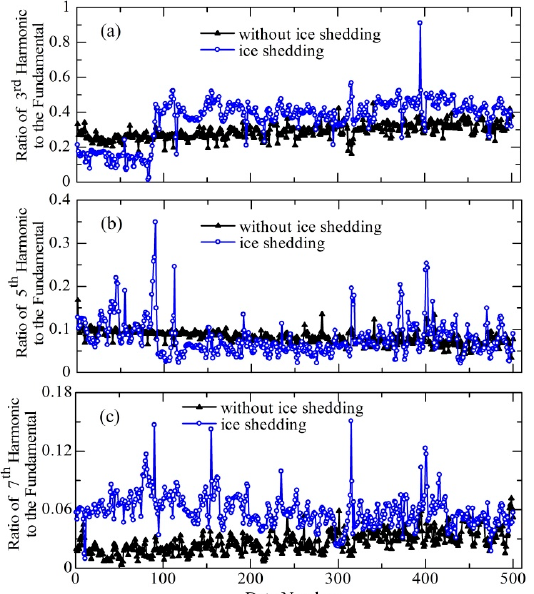
Figure 6. Ratio of different harmonics to the fundamental component during the flashover process of ice-covered insulators with and without ice shedding: ( a ) ratio of the 3rd harmonic to the fundamental; ( b ) ratio of the 5th harmonic to the fundamental; ( c ) ratio of the 7th harmonic to the fundamental.